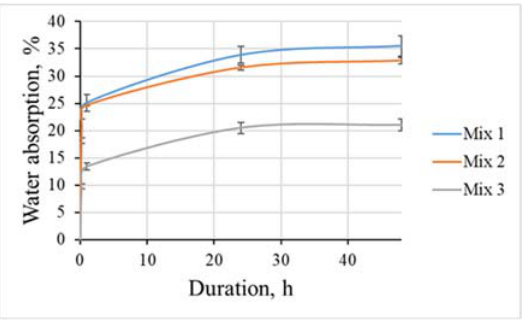
Figure 4. The kinetics of water absorption for lightweight aggregate shotcrete samples.